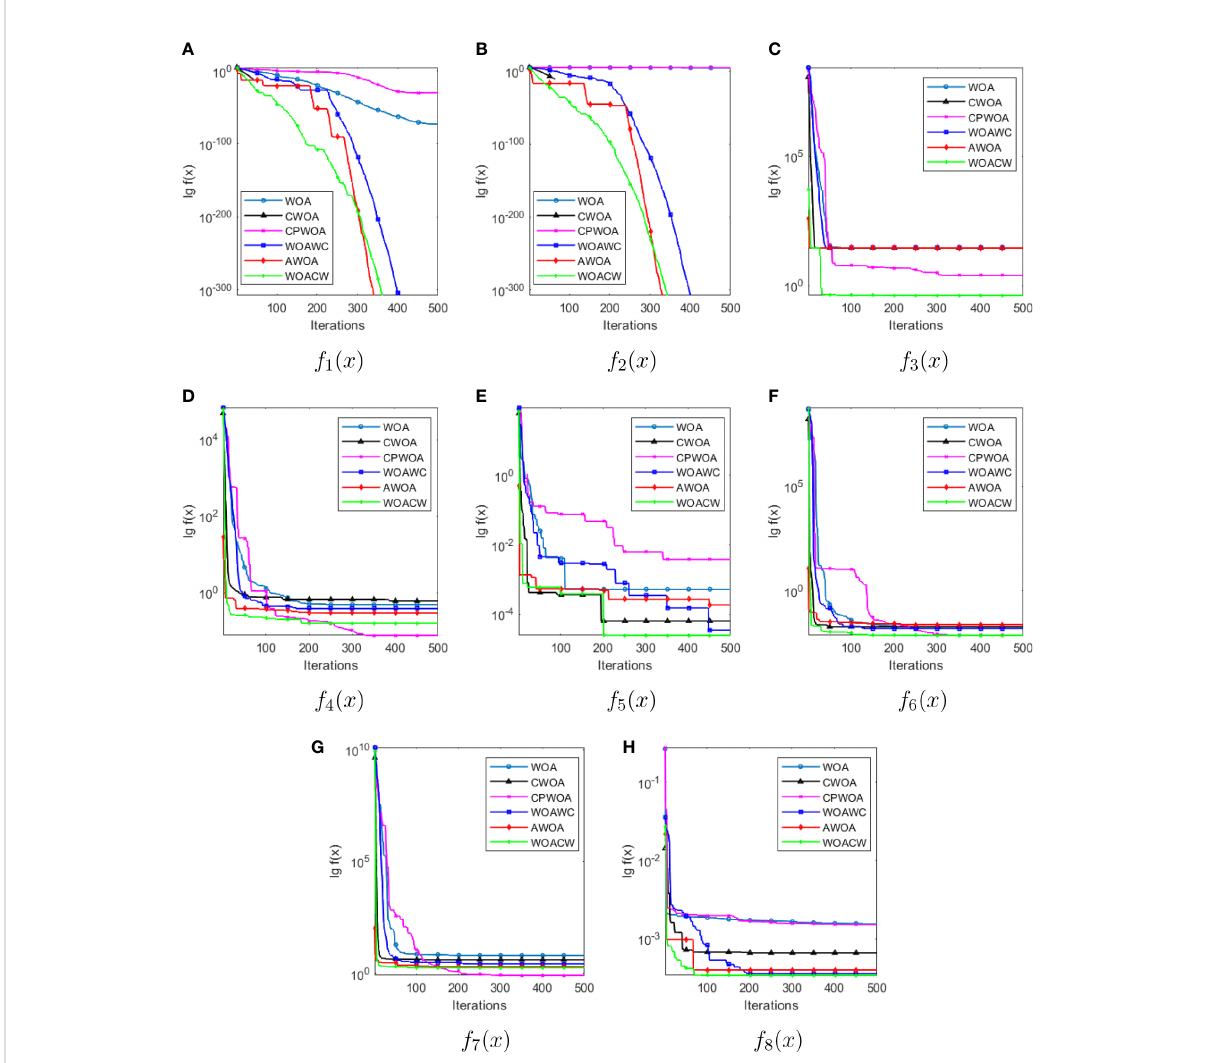
FIGURE 1 The convergence curves of WOA, CWOA, CPWOA, WOACW, AWOA and WOACW to f1(x)~f8(x) benchmark functions (as shown in sub- fi gure A – H respectively).